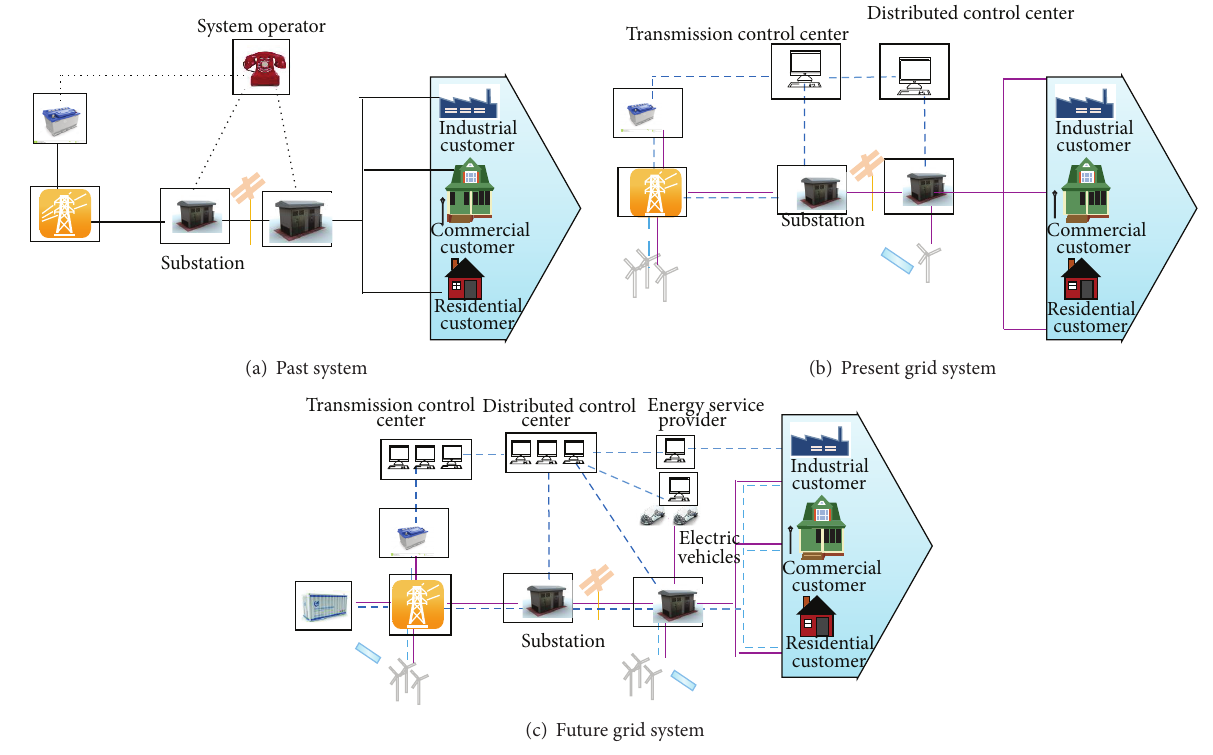
Figure 6: The comparison between conventional grid and smart grid